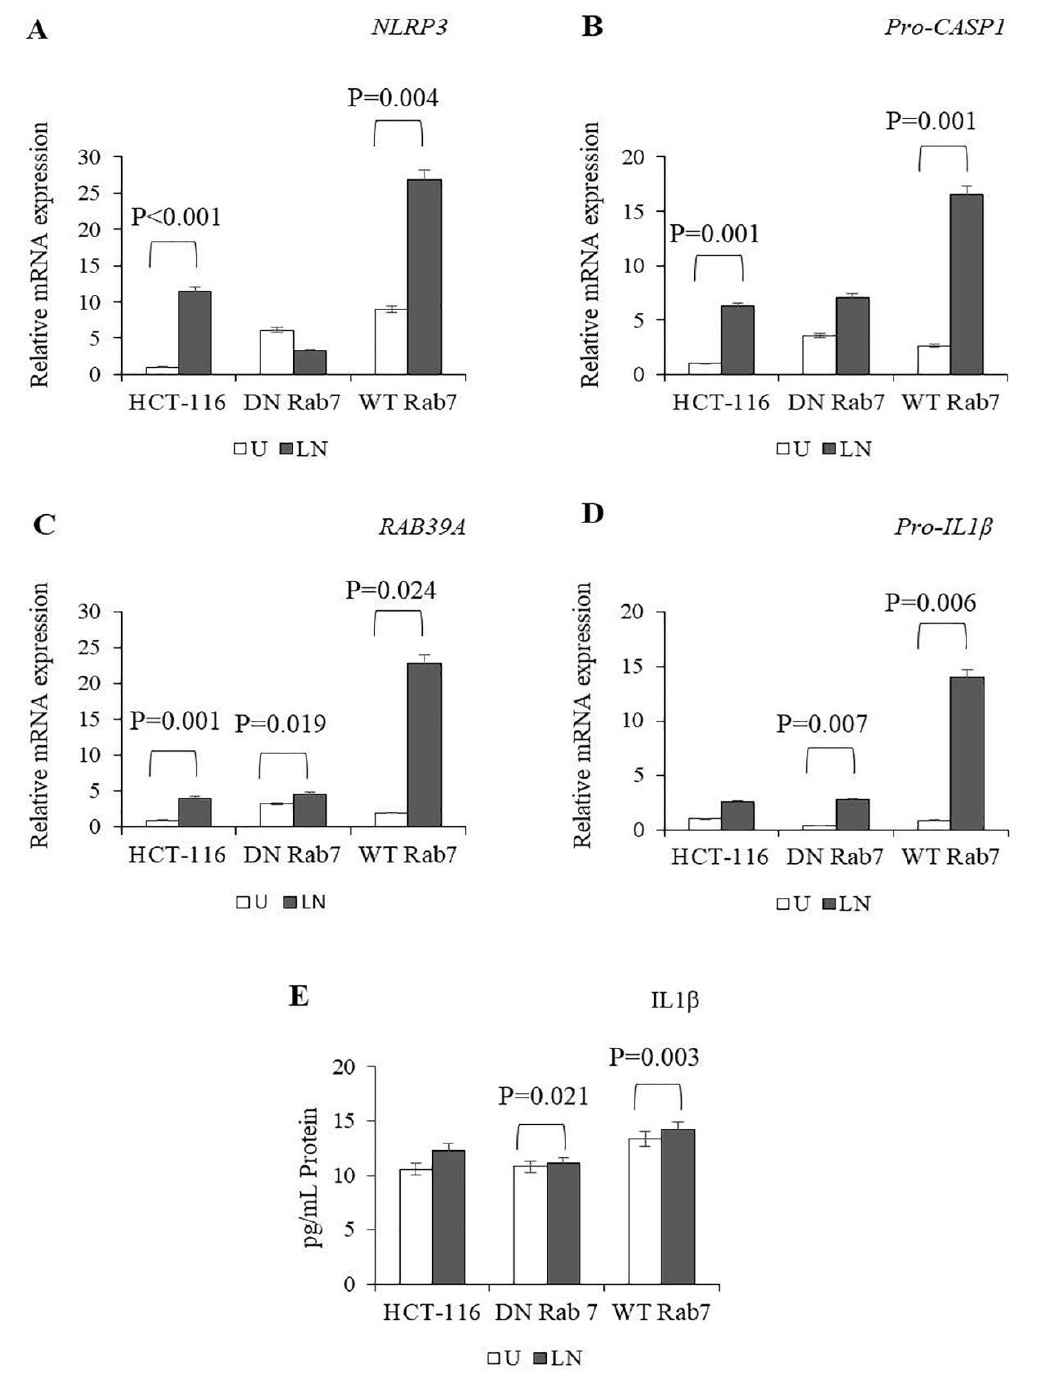
Figure 4. The e ff ects of Rab7 on NALP3 inflammasome activation. To assess NALP3 activation, HCT116 cells transfected with pDsRed-Rab7 WT and pDsRed-Rab7 DN were primed with LPS (1 µ g / mL) for three hours and then treated with nigericin (20 µ M) for 24 h. ( A – D ) The e ff ects of DN Rab7 and WT Rab7 on the expression of NLRP3 , RAB39A , Pro-CASP1 and Pro-IL1 β in the untreated and LPS / nigericin-treated HCT116 cells. ( E ) The e ff ects of DN Rab7 and WT Rab7 on IL1 β secretion in the untreated and LPS / nigericin-treated HCT116 cells. U: untreated; LN: LPS / nigericin-treated ( n = 3 for each experiment; p -values were calculated using independent sample T